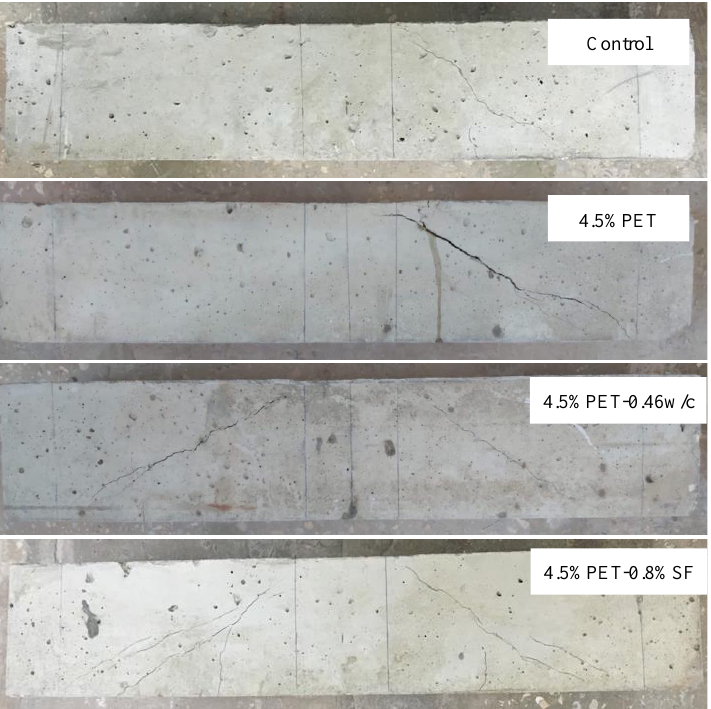
Figure 6. Crack patterns for the control and 4.5% PET-modified beams (i.e., shear testing).